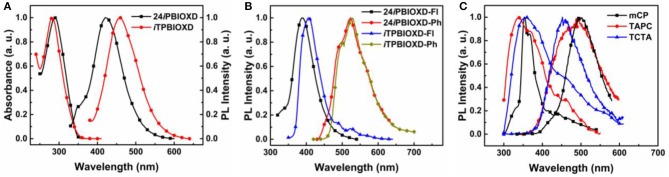
(A) Normalized UV-Vis absorption and PL spectra for 24iTPBIOXD and iTPBIOXD in CH2Cl2 solution, (B) 77 K fluorescence (Fl) and phosphorescence (Ph) spectra for 24iTPBIOXD and iTPBIOXD in neat film, (C) 77 K fluorescence (Fl) and phosphorescence (Ph) spectra for three donor materials in neat film.